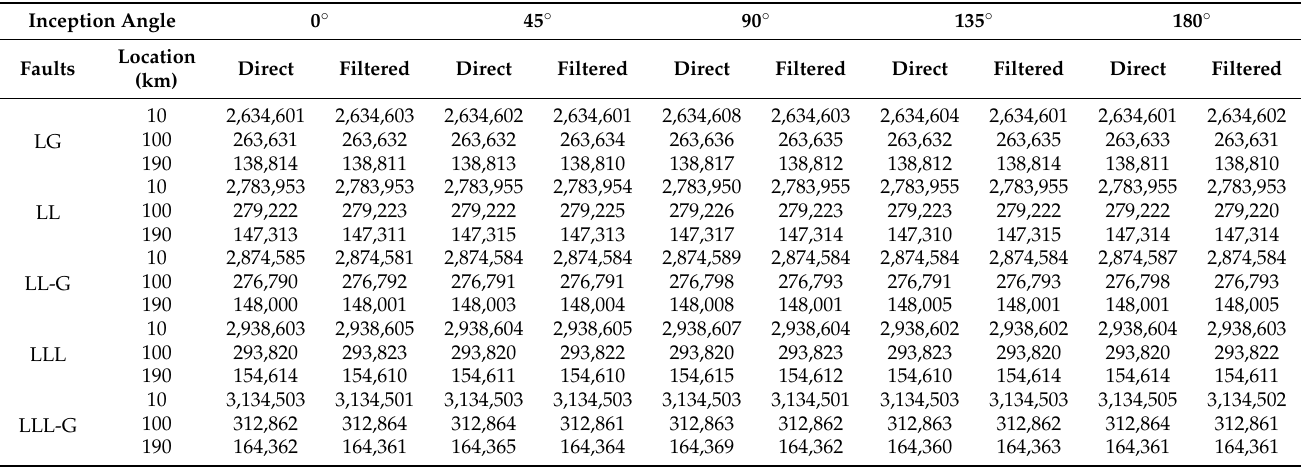
Table A8. Max singular values of FRFT-SVD results for direct and filtered current signals at various faults and inception angles with R = 200 Ω .